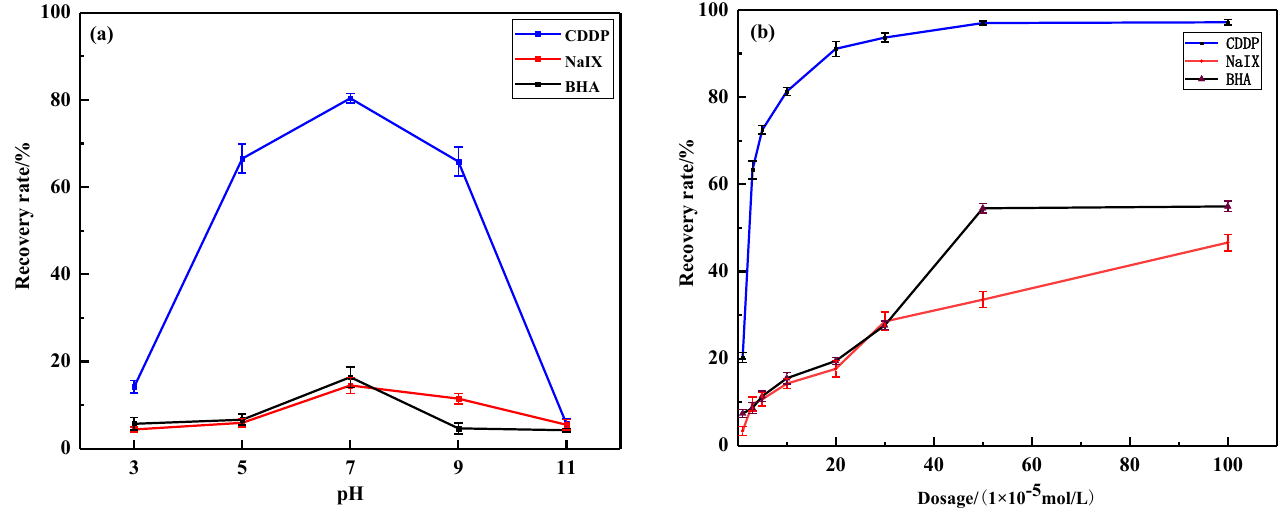
Figure 3. ( a ) Effect of pH value on azurite flotation; ( b ) effect of collector dosage on azurite flotation.